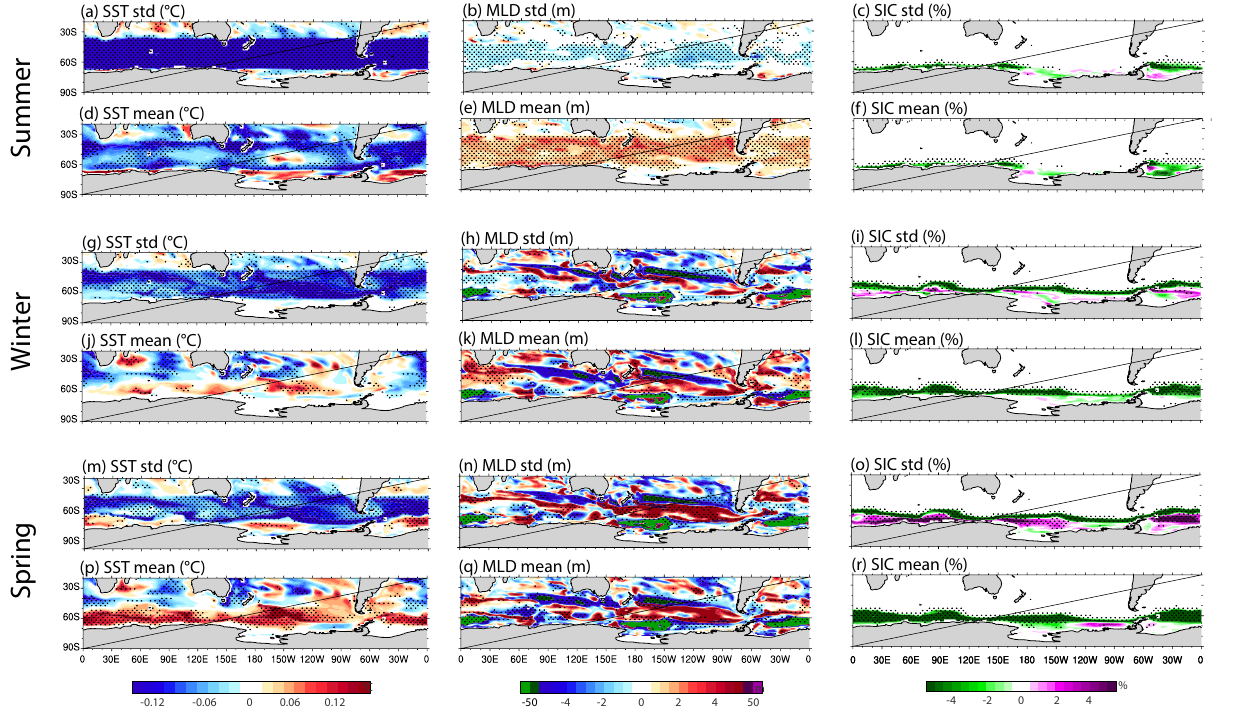
Figure 3. Seasonal standard deviation and mean-state differences (SOclimSST minus CTRL) for: (top two rows) late summer (JFMA), (middle two rows) winter (MJJA), and (bottom two rows) spring (SOND). (left columns) SST, (middle columns) MLD, (right columns) SIC. As in Fig. 1, stippling indicates robustness in the sign of the ensemble-mean difference, where the sign of all six individual differences (each SOclimSST run minus each CTRL run) is the same. Figure produced using the NCAR Command Language (https:// doi. org/ 10. 5065/ D6WD3